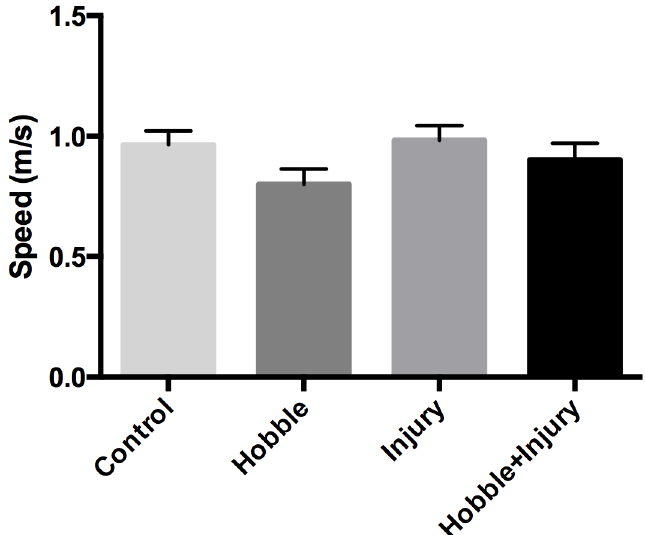
Fig 5. Gait analysis. Gait speed (m/sec) was measured at week 8. There was a significant main effect of movement restriction on gait speed (ANOVA p = .03), but no significant effect of injury (ANOVA p = 2 . 56)